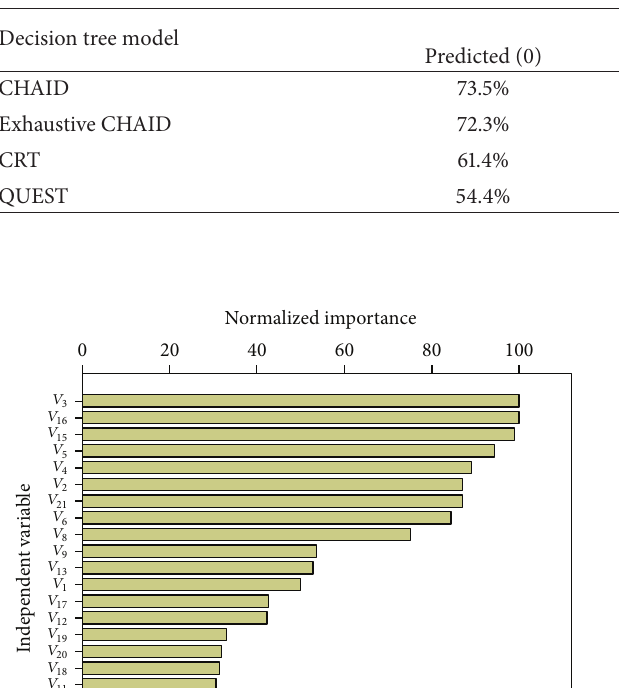
of the decision tree model for landslide hazard